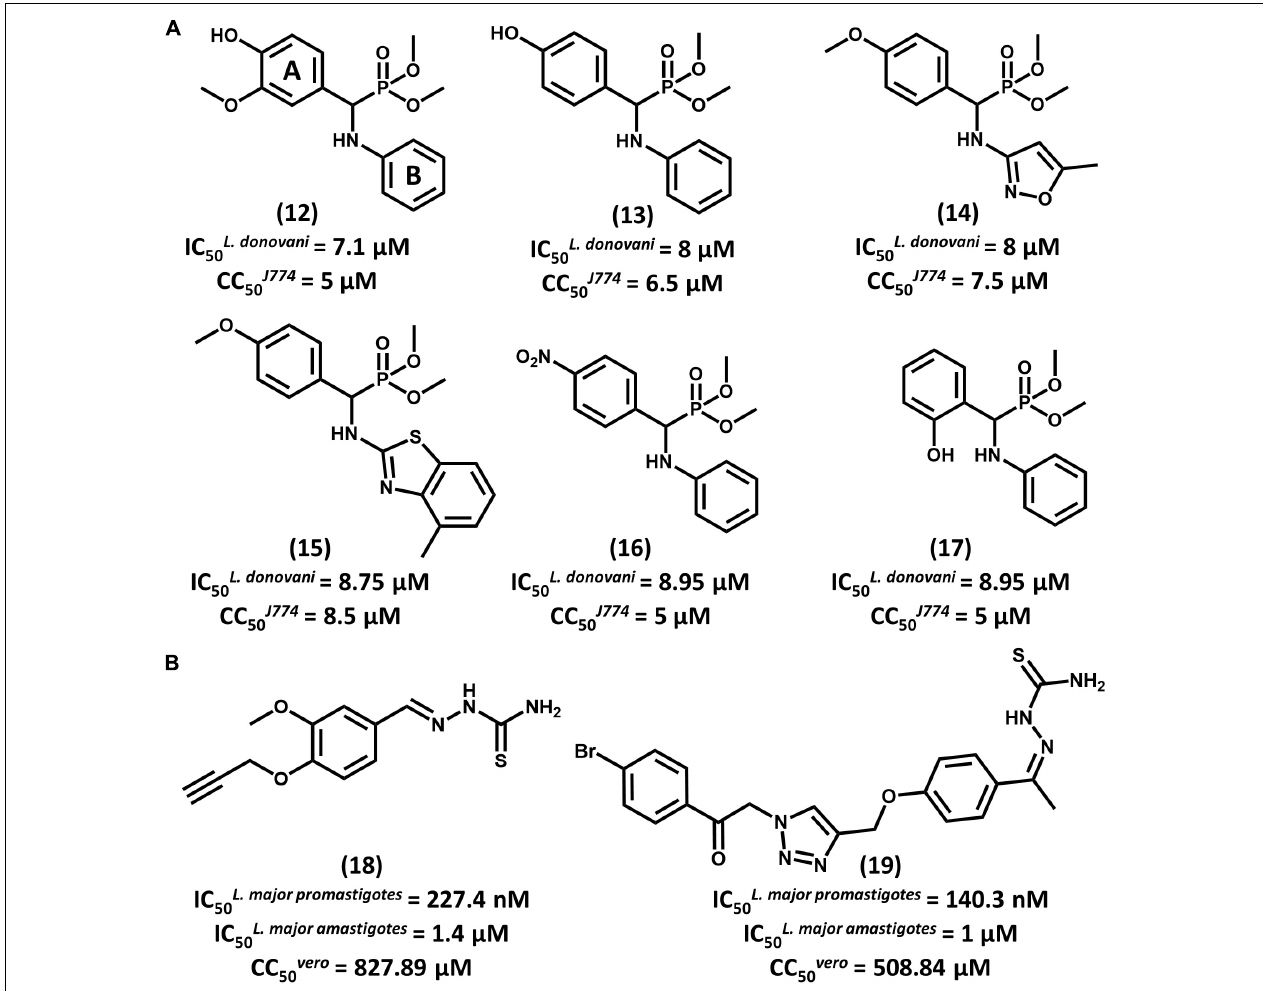
FIGURE 7 | (A) A series of aminophosphonate derivatives as novel compounds featuring antiparasitic activity against L. donovani promastigotes. The QSAR models assigned rings A and B as the most relevant sites for molecular modification. (B) Triazole and thiosemicarbazone hybrids 18 and 19 showed promising activity against L. major promastigotes and